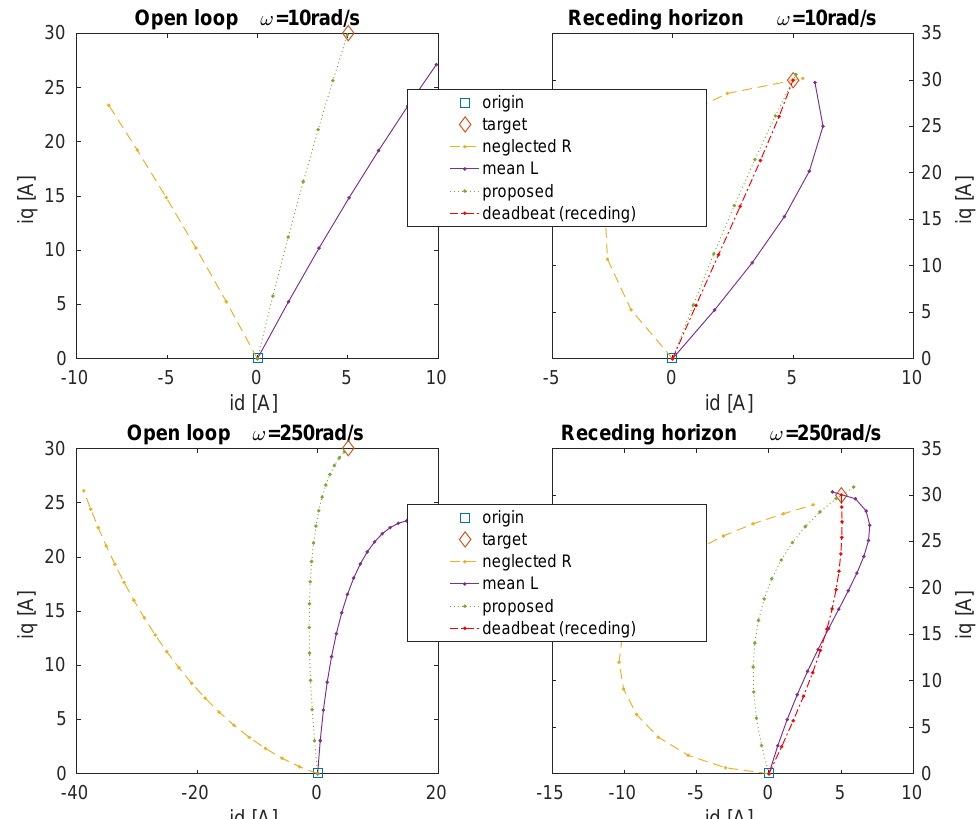
Figure 3. Comparison of studied versions of time-optimal control and deadbeat control on current reference step change from zero to [ 5,30 ] A for modified parameters of the system with lower inductance at ω = 10 rad/s ( top row), and ω = 250 rad/s ( bottom row). The difference of the solutions in the origin is visible in open-loop strategy ( left ), its impact on the receding horizon reevaluation in each sampling period ( right ), sampling times are denoted by dots on the full